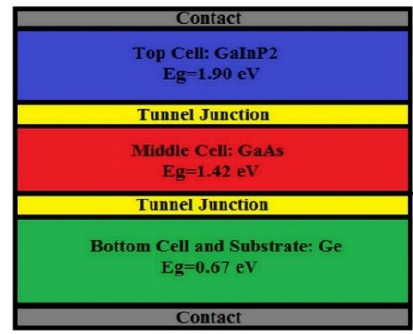
Figure 2. Structure of triple junction cell based on GaInP 2 /GaAs/Ge [42].